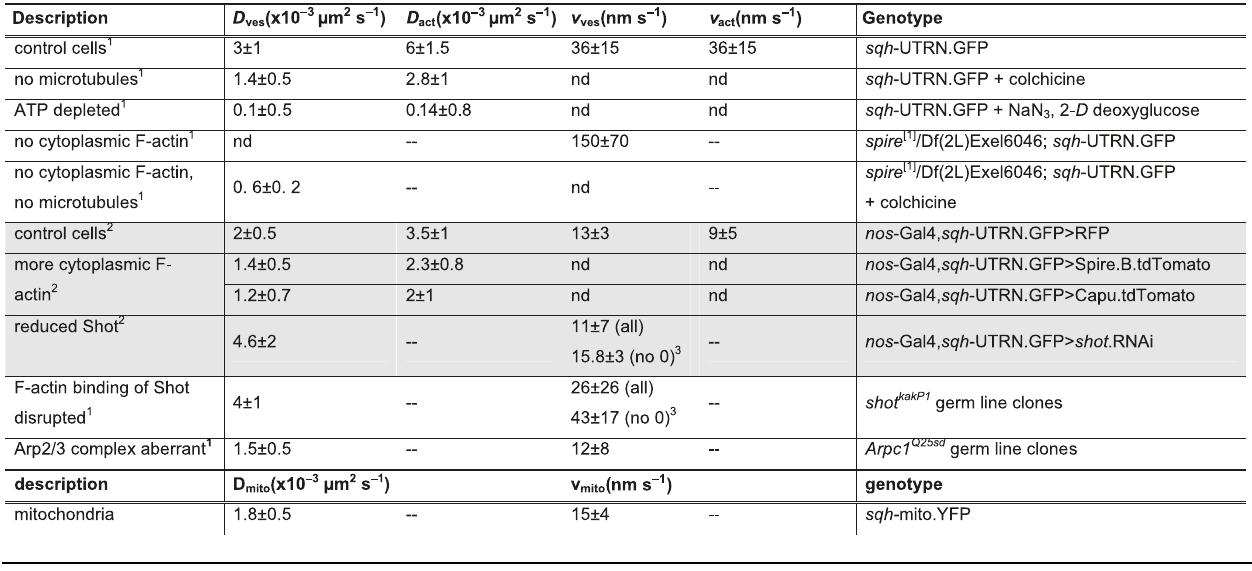
Table 1 Summary of motion